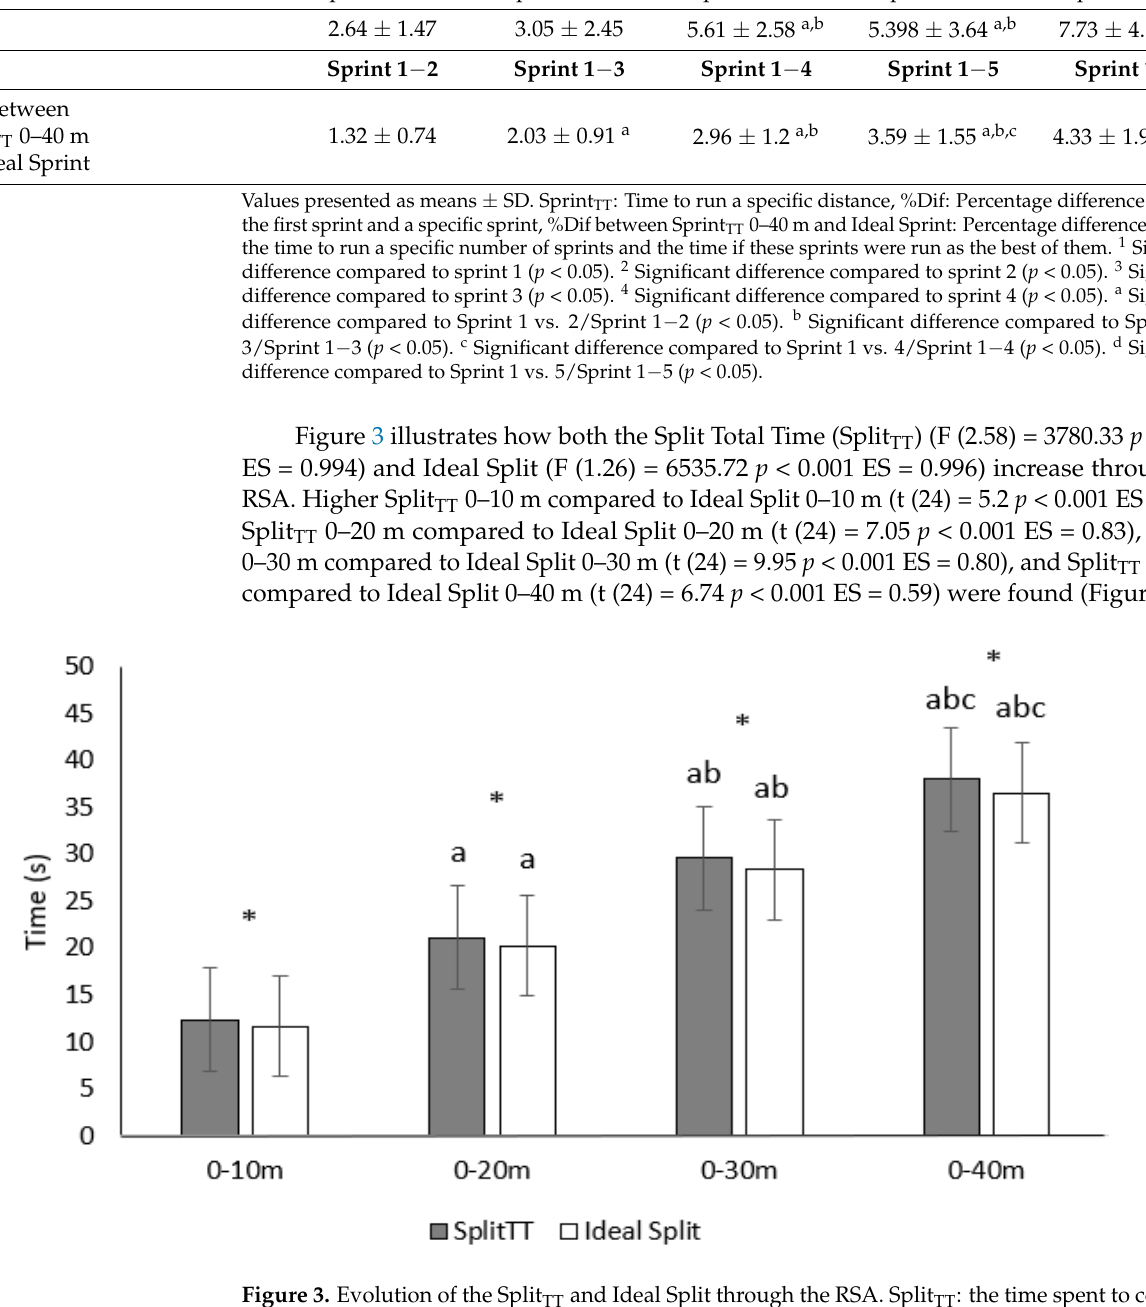
Figure 3. Evolution of the Split TT and Ideal Split through the RSA. Split TT : the time spent to complete a specific distance during the six sprints, Ideal Split: the Split TT if all the splits were run as the best of them. * Significant difference between Split TT and Ideal Split. a Significant difference compared to 0 − 10 m ( p < 0.05) b Significant difference compared to 0 − 20 m ( p < 0.05) c Significant difference compared to 0 − 30 m ( p < 0.05).